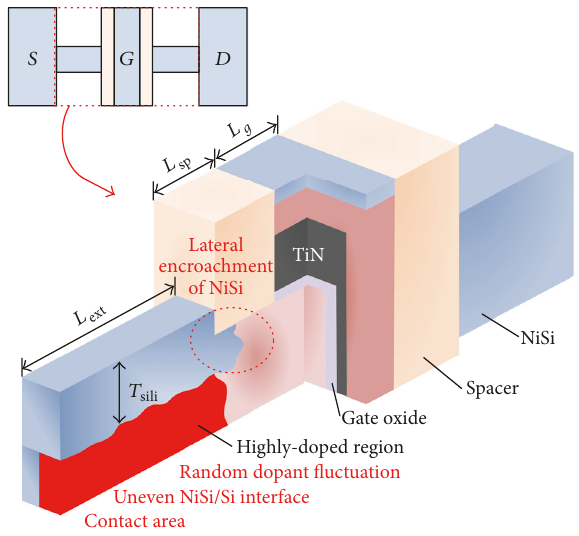
Figure 1: 3D schematic diagram of the SOI FinFETs. Geometrical parameters such as gate length ( 𝐿 𝑔 ), spacer length ( 𝐿 ), extension sp length ( 𝐿 ), and silicide thickness ( 𝑇 ) are also specified. Top left ext sili figure describes the real device structure, and red-colored phrases indicate the possible variability